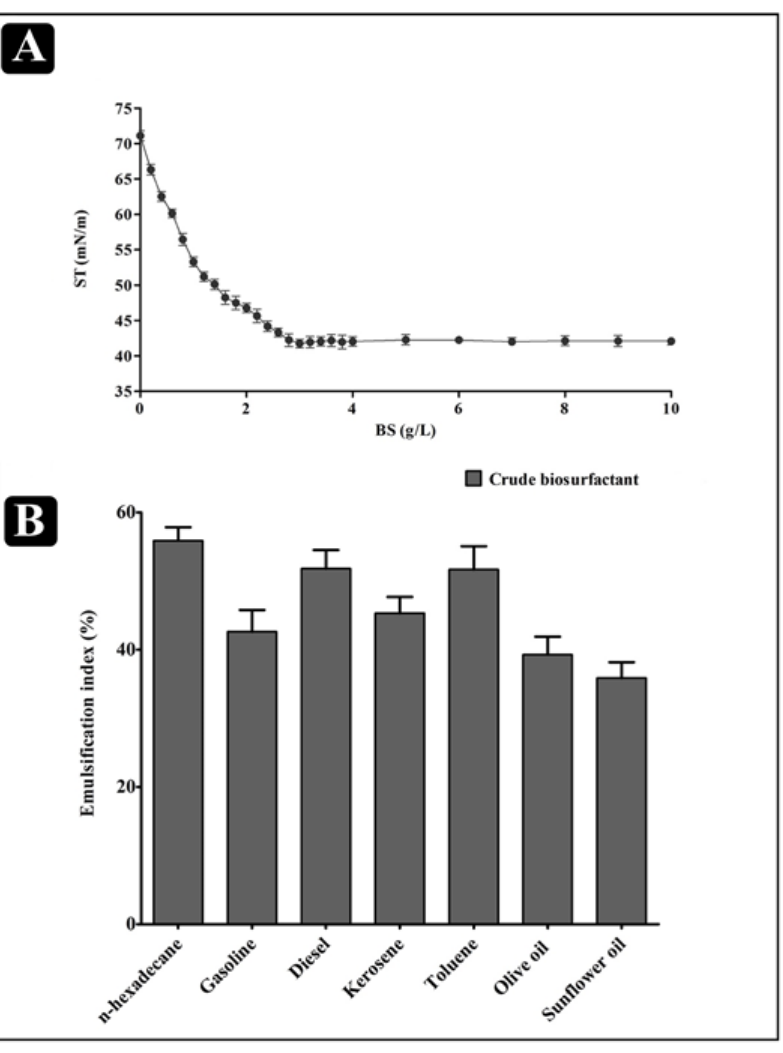
Figure 2. Results of the physical properties of the L. rhamnosus crude biosurfactant (BS). ( A ) Progres- sive decrease in surface tension (ST) with increase in concentration of biosurfactant up to 3.0 g/L. ( B ) %EI24 of the cell-bound biosurfactant against different substrates. Values are the mean ± SD of three independent experiments.